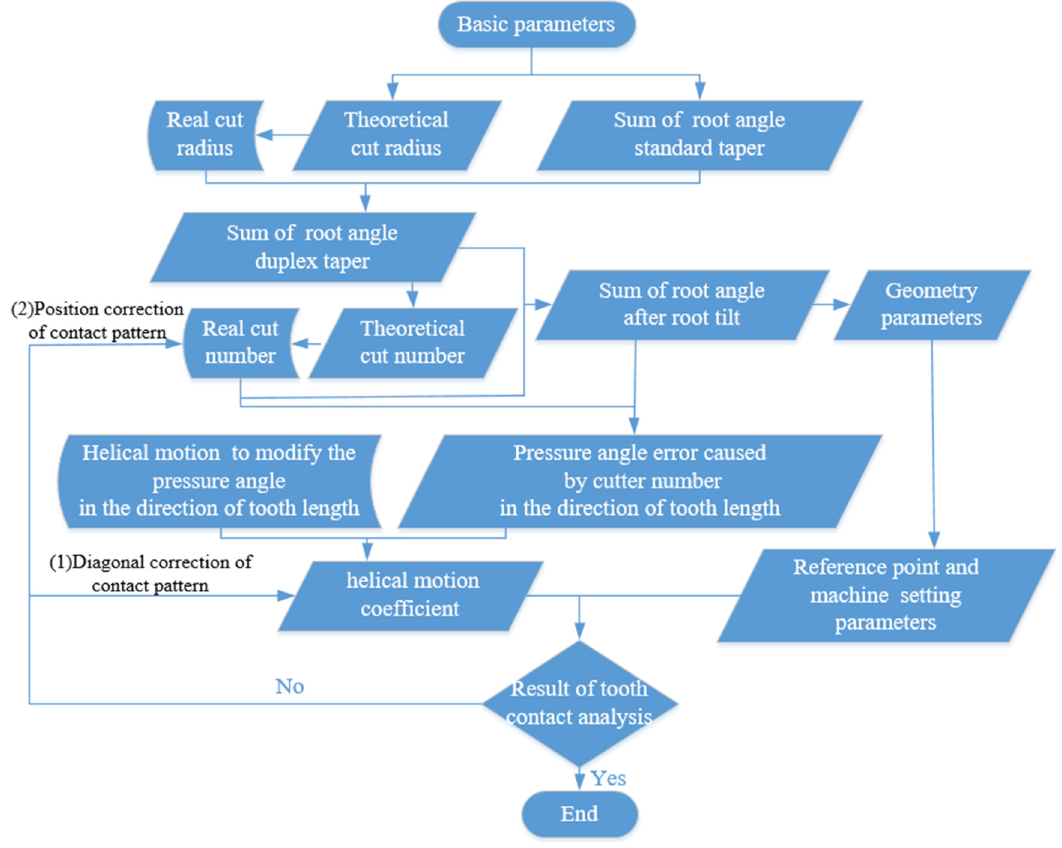
Fig. 5. Flow chart of technological process. Table 1. Geometric